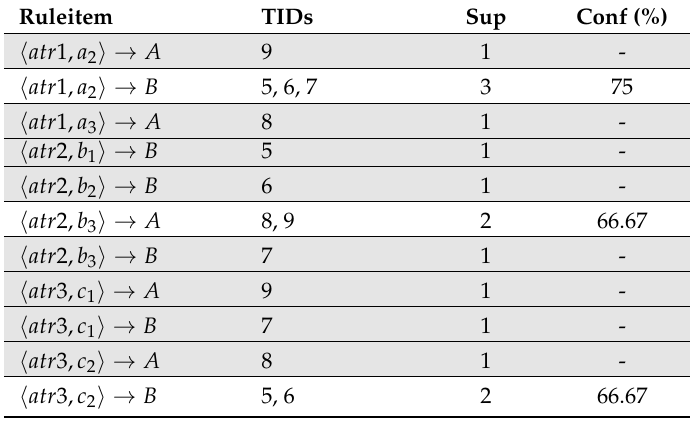
Table 4. The remained transaction IDs after generating the first Class Association Rule